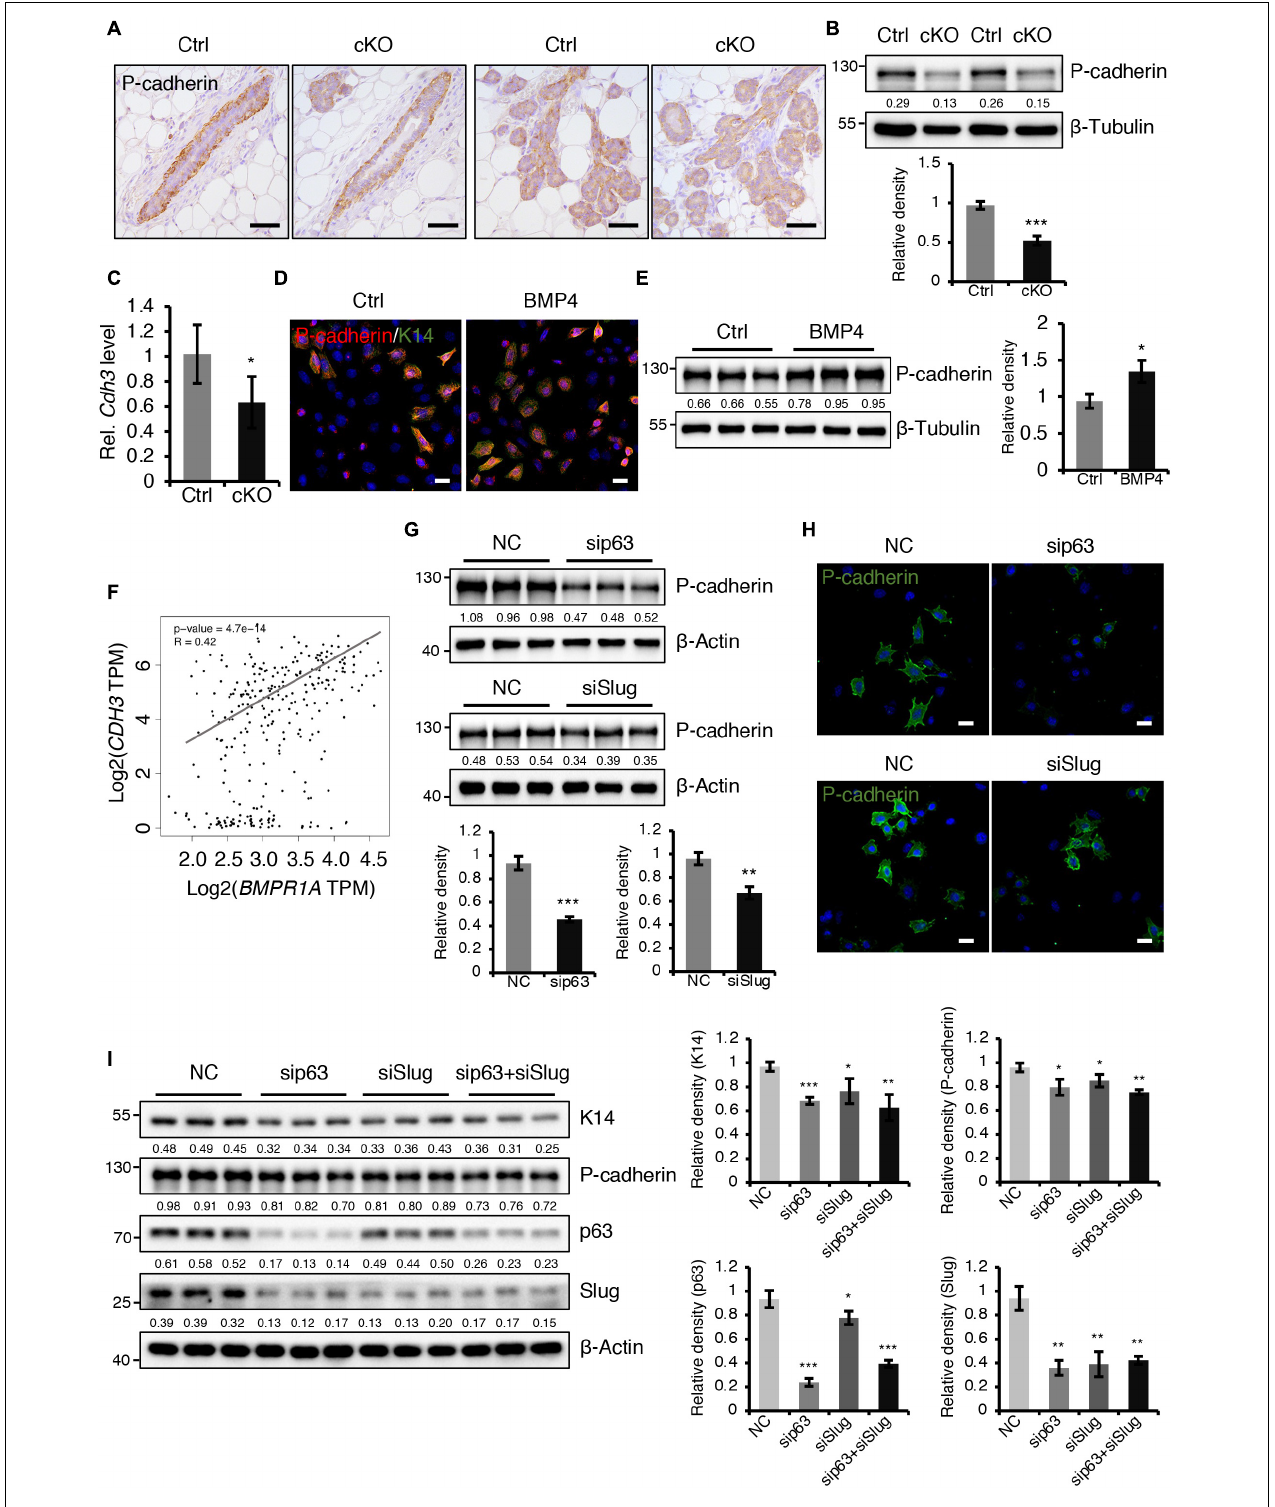
FIGURE 6 | BMPR1a regulated P-cadherin expression via p63 and Slug. (A) Immunohistochemistry staining for P-cadherin in control ( n = 4 mice) and cKO ( n = 3 mice) mammary glands at pregnancy day 14.5. Scale bar, 50 µ m. (B) Western blotting for P-cadherin in mammary epithelial cells isolated from control and cKO mice at pregnancy day 14.5. β -Tubulin was used as a loading control. Statistical analysis the expression of P-cadherin/ β -Tubulin. n = 3 mice. (C) qRT-PCR analysis of Cdh3 in FACS-sorted control and cKO myoepithelial cells at pregnancy day 14.5. n = 4 biological replicates. (D) P-cadherin (red) and K14 (green) double